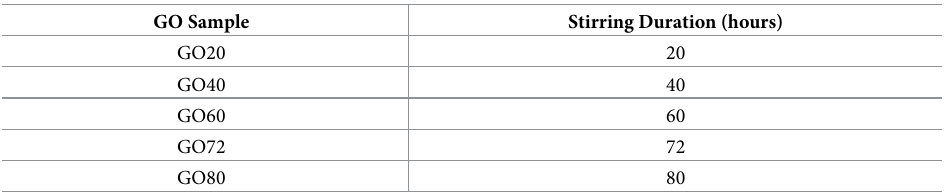
Table 1. Synthesis parameter of